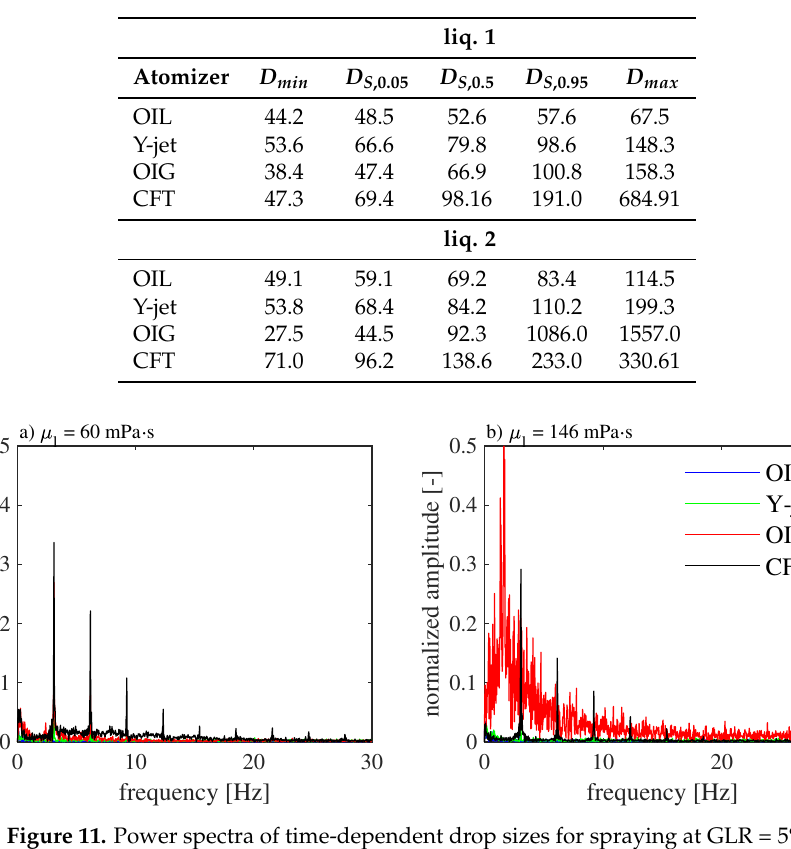
Table 8. Parameters of the spray drop size distribution at GLR = 5%.